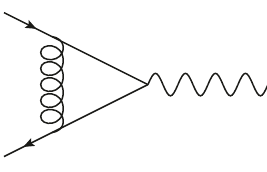
Figure 3 . A two-loop γZ box-type diagram for the mixed EW-QCD corrections of relative order αα s to the neutral-current Drell-Yan process which receives a correction from the insertion of a finite one-loop counterterm ( δZ (0 , 1) of eq. (2.113)) into a corresponding one-loop box diagram. Z ¯ qq